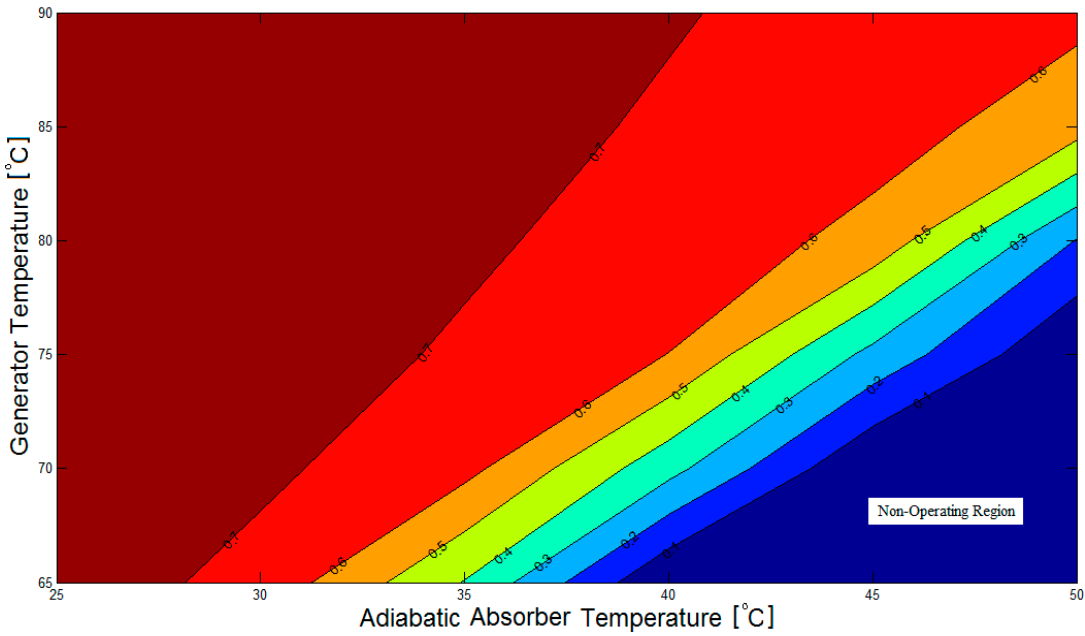
Figure 3. Contour plot of the COP (coefficient of performance) of the LiBr/water absorption